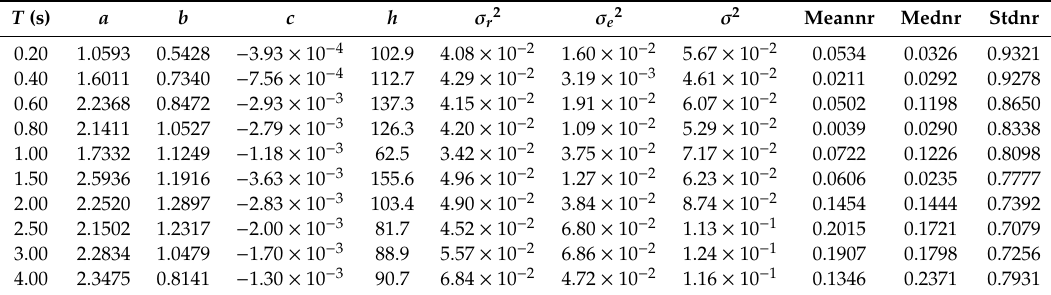
Table A2. Coe ffi cients of the GMPE for set 1, Equation (1), ground type C.